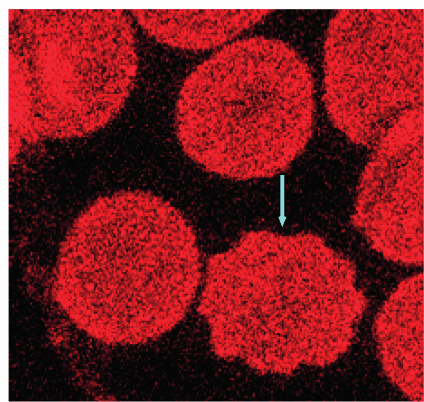
Figure 11. Phalloidin–Rhodamin stained erythrocytes, echinocytic shape change marked by the blue arrow (reprinted from reference [23], Copyright 2013, with permission from IOS Press; primary magnification 1:63, zoom factor: